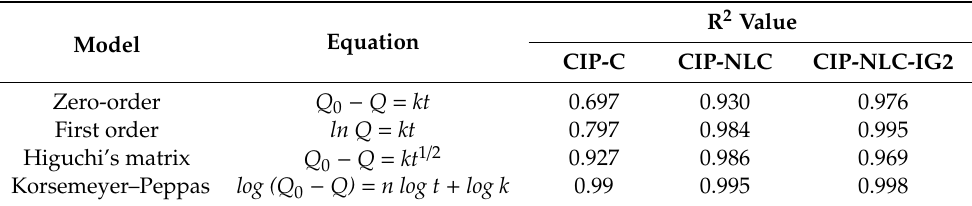
Table 6. Mathematical model fitting of release kinetics of CIP from optimized CIP-NLC, optimized CIP-NLC-IG, and CIP-C formulations.